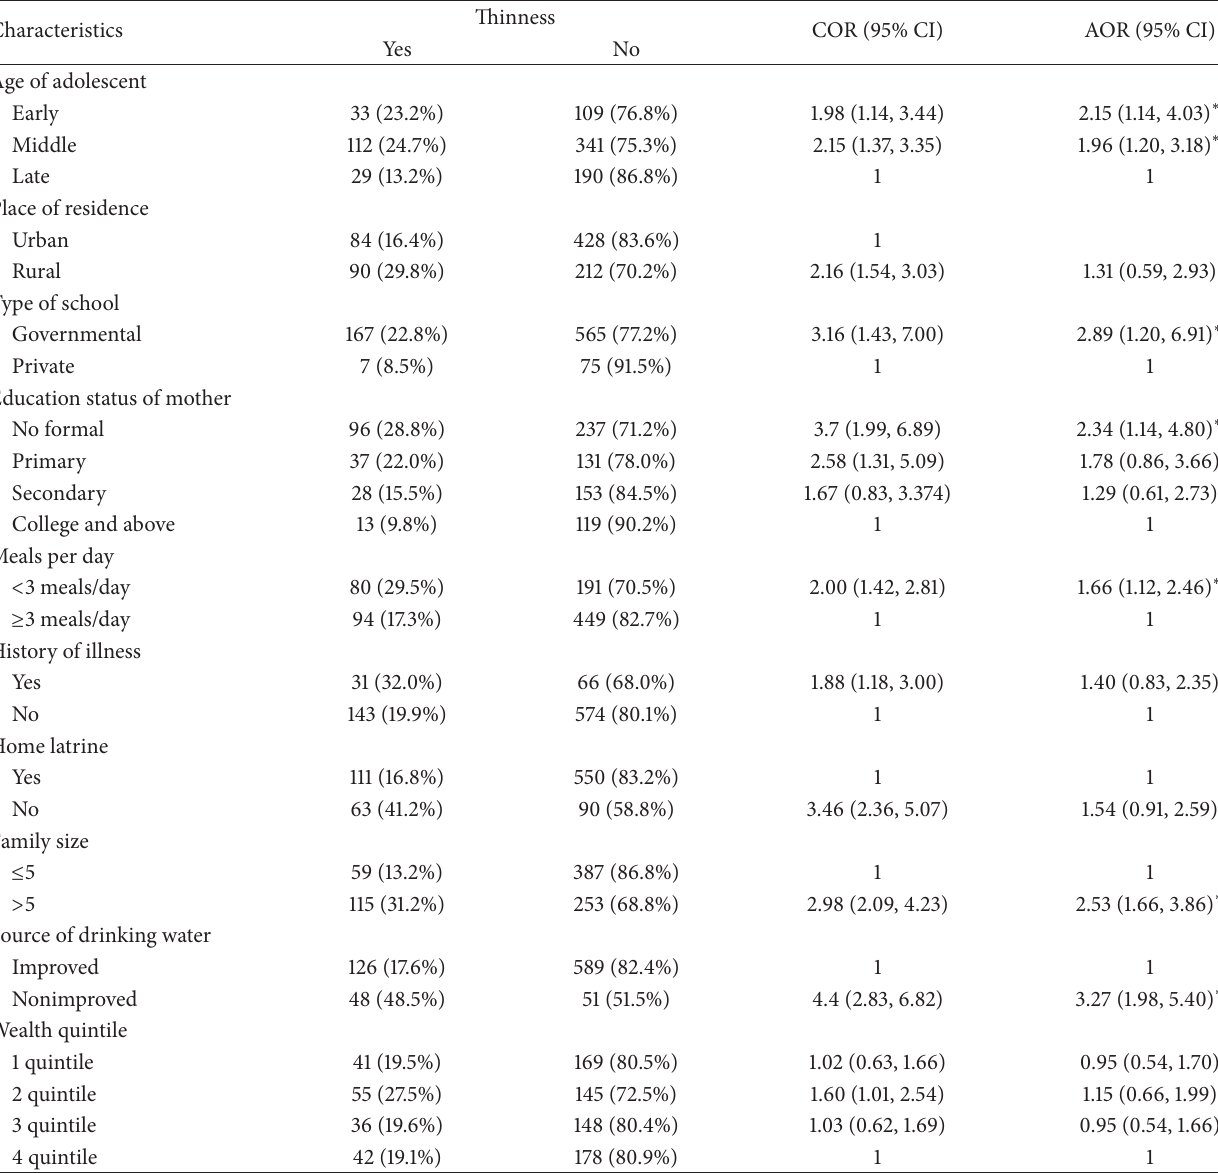
Table2:Bivariateandmultivariatelogisticregressionoffactorsassociatedwiththinnessamongadolescentschoolgirls,Adwatown,Northern Ethiopia,